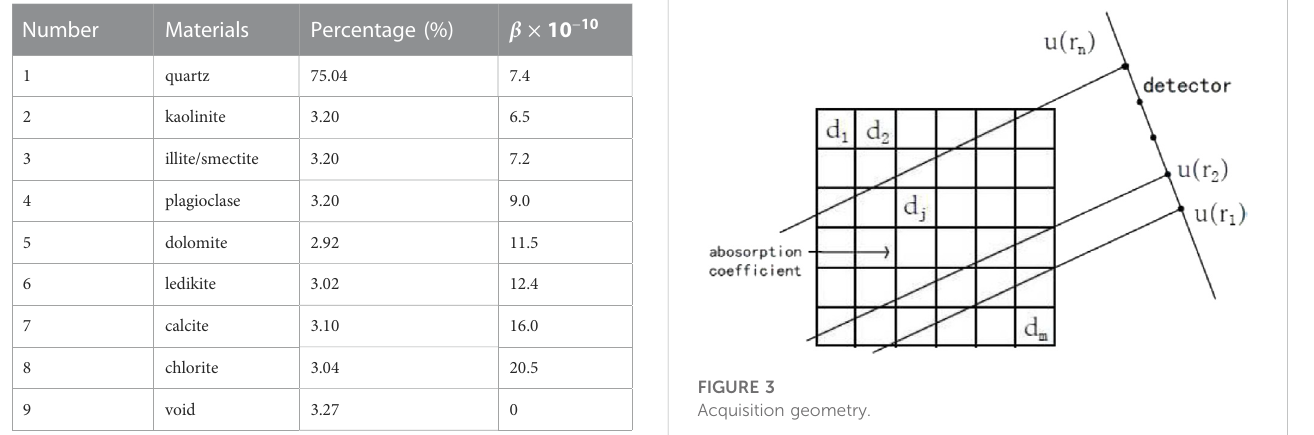
TABLE 1 Theoretical β values for materials in the model at E=30 Kev.